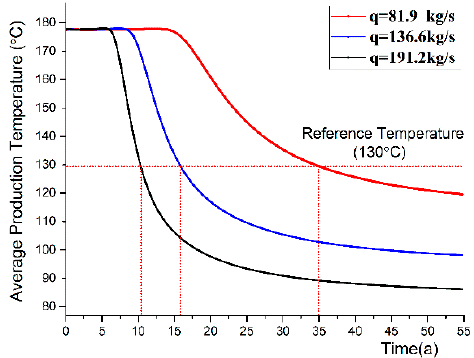
Figure 16. Average production temperature curves of three enhanced geothermal system (EGS) cases with different injection rates.